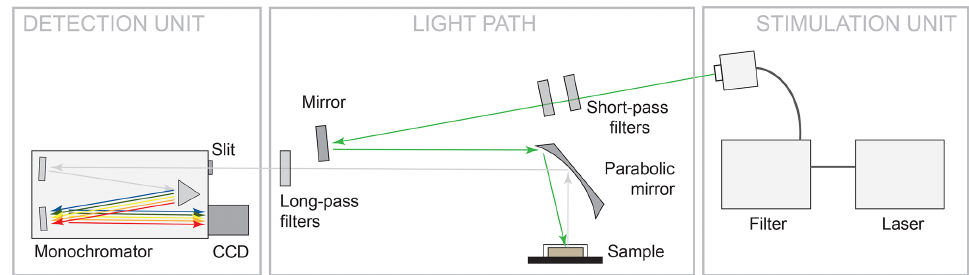
Figure 2. Scheme of technical setup for the laser-induced fluorescence (LiF)